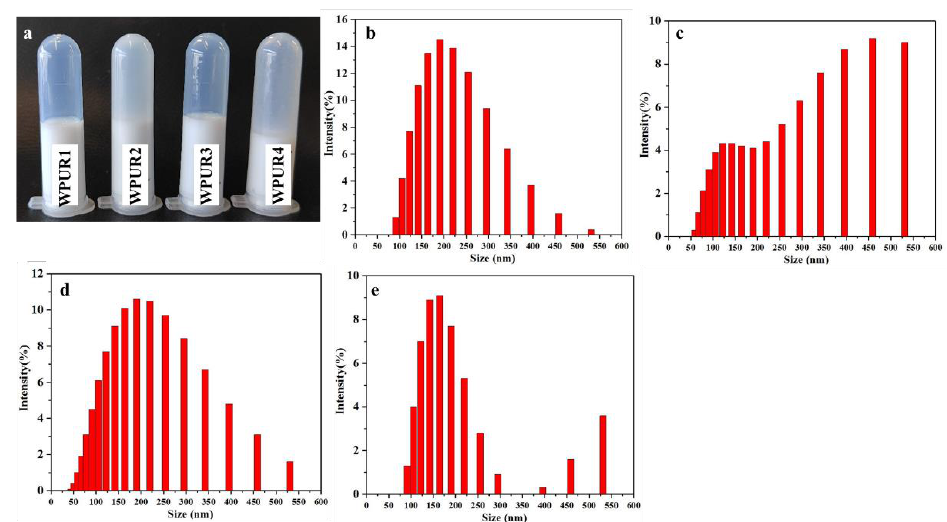
Figure 2. ( a ) The photographs of WPUR1, WPUR2, WPUR3 and WPUR4. The particle sizes and distribution of WPUR1 ( b ), WPUR2 ( c ), WPUR3 ( d ) and WPUR4 ( e ), respectively.